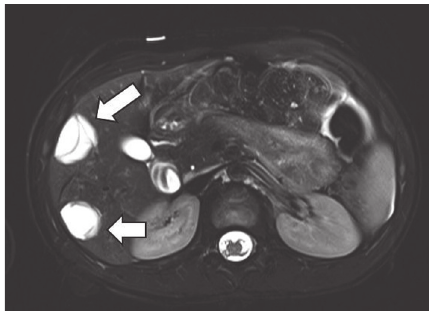
Figure 3: MRI scan of the patient no.3: multiple cysts up to 2.7cm in S8/5, S7/6, S7, and S2/4 of the liver.